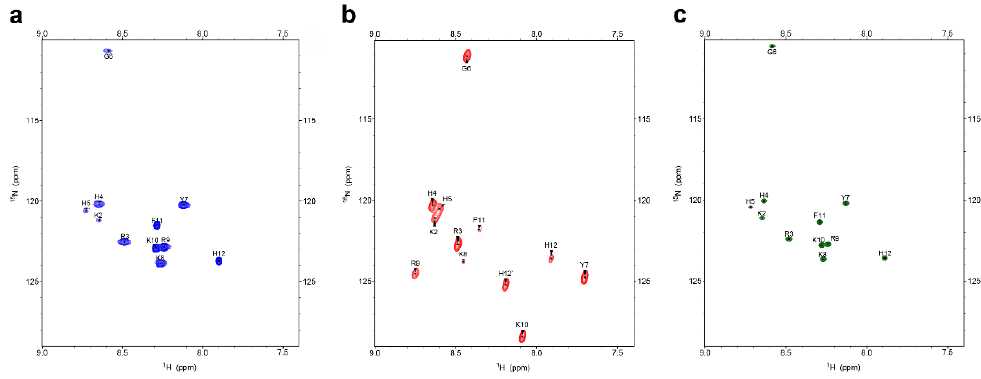
Figure 1. 1 H- 15 N HSQC NMR spectra of 0.25 mM P-113 peptides presented in ( a ) broth only, ( b ) 10 7 colony-forming units (CFU) / mL of Candida Albicans , and ( c ) 10 7 CFU / mL of C. albicans + 0.5 mM pepstatin A at 301 K for 24 h. The chemical shifts of P-113 peptides moved dramatically after C. albicans titration. However, these shifts were inhibited by the protease inhibitor pepstatin A.